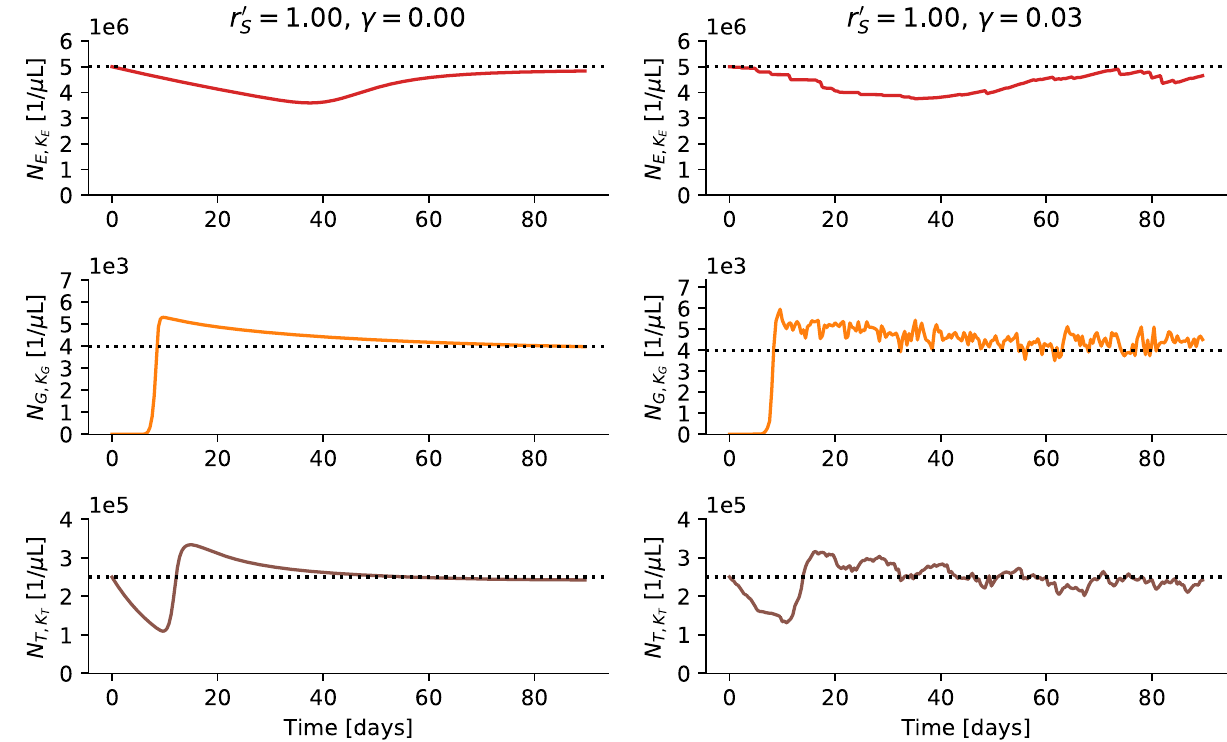
Fig 3. Simulation of stem cell transplant. The left side panels depict erythrocyte, granulocyte, and thrombocyte counts for a simulation of a stem cell transplant (for details see main text). The right side panels show the same with increased noise scaling.